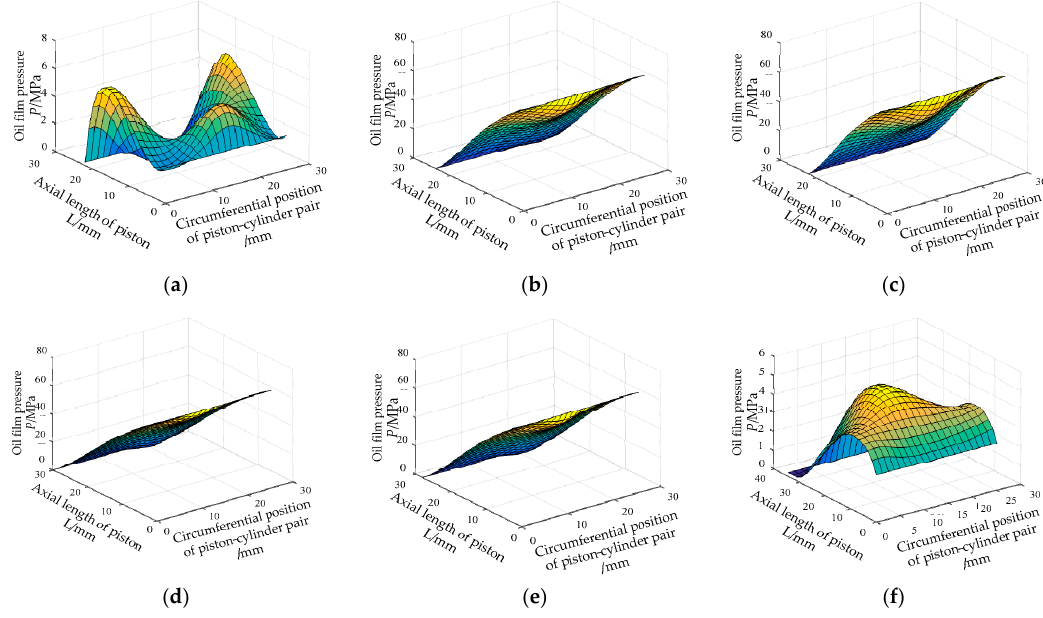
Figure 10. The figure shows the distribution of oil film pressure under different inclined plate rotation angles under ultra-high pressure conditions: ( a ) Oil film pressure distribution with swashplate rotation of 1°; ( b ) oil film pressure distribution with swashplate rotation of 10°; ( c ) oil film pressure distribution with swashplate rotation of 45°; ( d ) oil film pressure distribution with swashplate rotation of 90°; ( e ) oil film pressure distribution with swashplate rotation of 110°; ( f ) oil film pressure distribution with swashplate rotation of 210°.